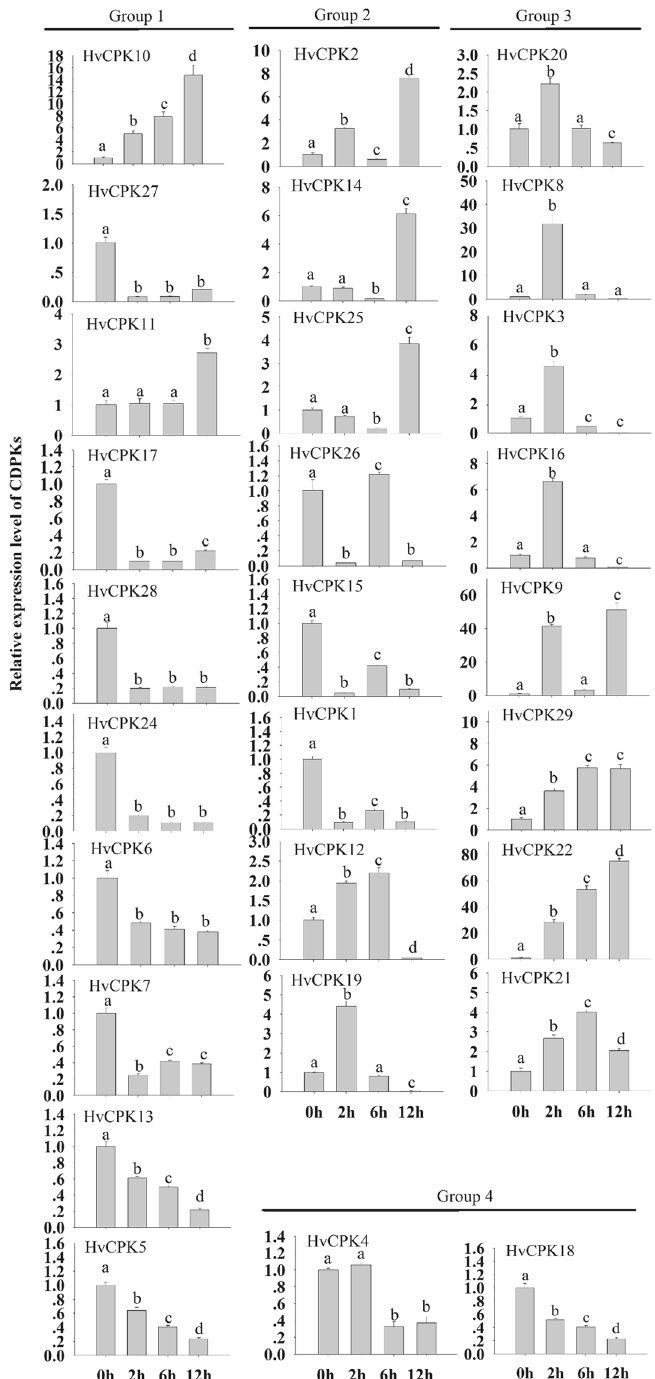
Figure 4. Expression profiles of the HvCDPK genes during MeJA treatment. qPCR analyses were performed, and expression values were calculated using the 2 −ΔΔ CT method. Data are mean values ± SE obtained from three replicates. Different letters within a column indicate a significant difference (P < 0.05; Tukey’s